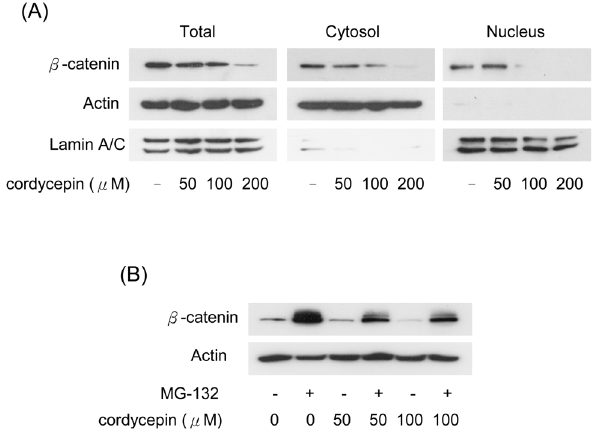
Figure 4. Cordycepin reduces b -catenin via proteasome dependent degradation. (A) U937 cells were treated with different concentrations (50 to 200 m M) of cordycepin. Nuclear and cytosolic fractions were extracted and the expression of b -catenin was determined by Western blot analysis. Actin and lamina/C were used as the loading control for cytosolic and nuclear fractions, respectively. (B) U937 cells were treated with 50 or 100 m M of cordycepin combined with/without MG-132 (10 m M) for 4 hrs. Expression levels of b -catenin were determined by Western blot analysis. Actin was used as a loading